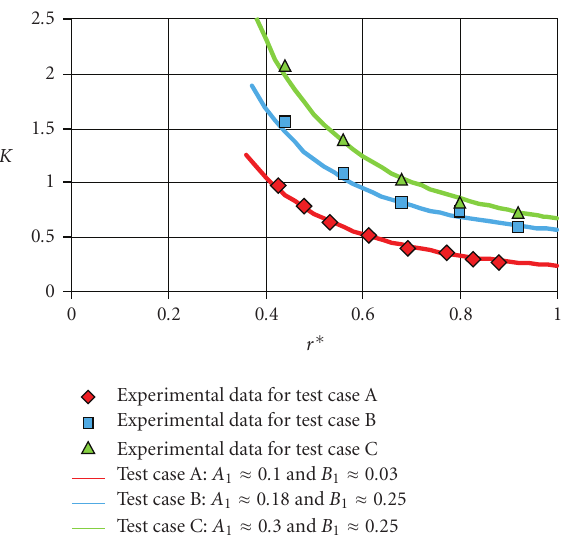
Figure 11: Core swirl ratio distribution.